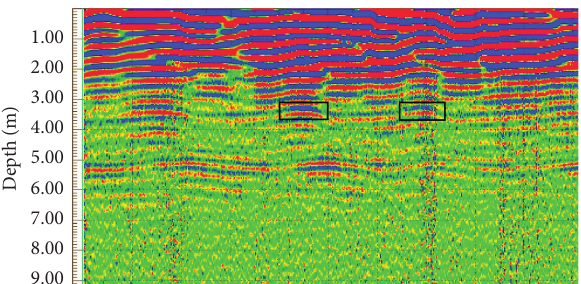
Figure 15: Radar image in a color.